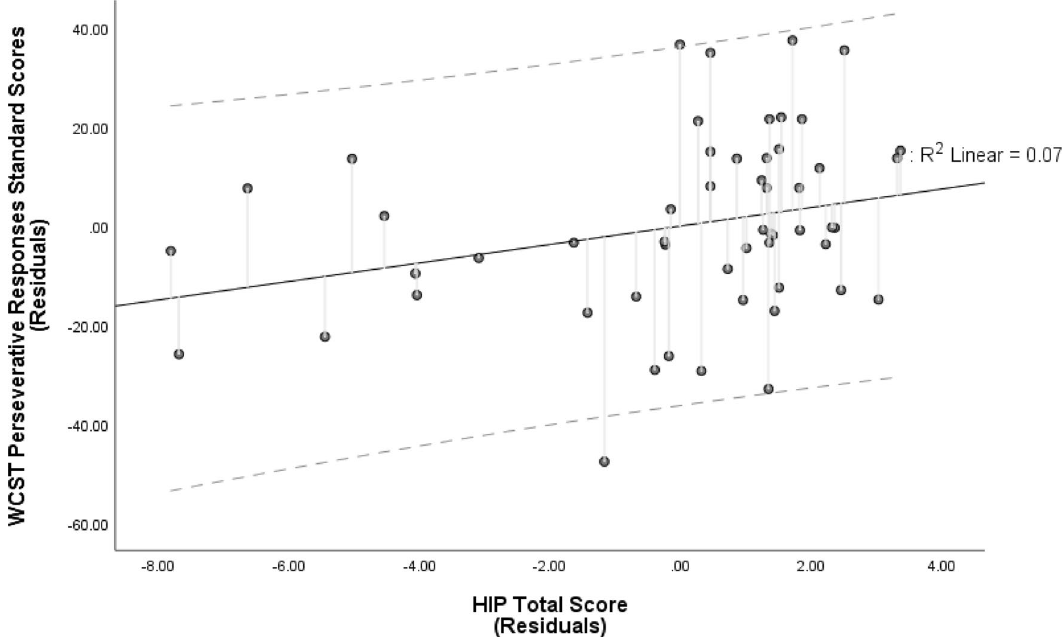
Figure 3. Partial regression plot of the model predicting Perseverative Responses Standard Scores on the Wisconsin Card Sorting Test (WCST) by Hypnotic Induction Profile (HIP) Total Score. The relationship between WCST Perseverative Responses and the HIP total score, after controlling for age and years of education. HIP scores were the only significant predictor of Perseverative Responses Standard Score (higher Standard Scores reflect less perseverative responding). The broken lines represent 95% prediction